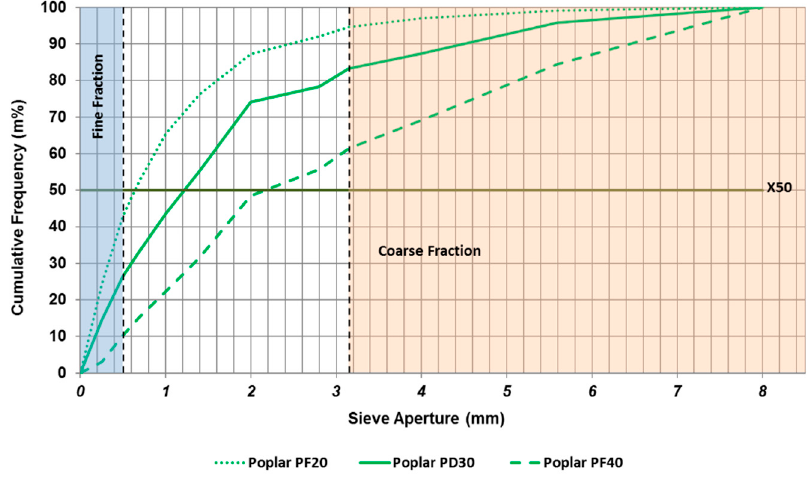
Figure 6. Particle size distribution of poplar fibre produced by the extruder at ATB at 20 mm, 30 mm and 40 mm aperture setting. Table 3. Comparison of different extruded materials for fine fraction, coarse fraction and X50-value at 20 mm aperture and peat, coir and sand (not extruded).